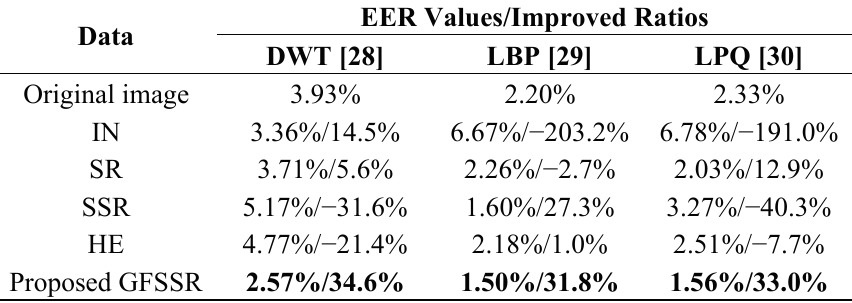
Figure 11. ROC curves of different image enhancement methods on MMCBNU_6000 using different feature extraction algorithms: ( a ) DWT method; ( b ) LBP method; and ( c ) LPQ method. Table 1. EER values and their improved ratio achieved using different feature extraction algorithms on